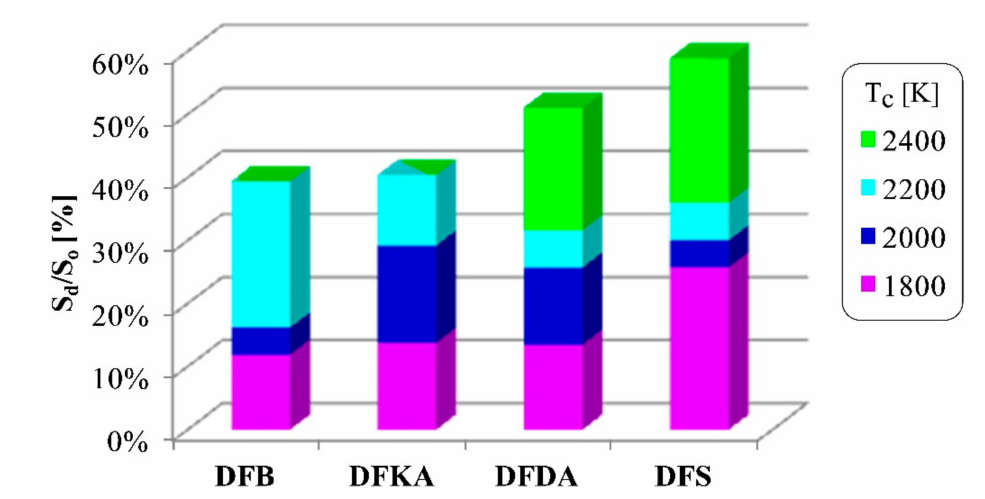
Figure 33. Surface area S d of flame in diffusion phase of combustion covered by isotherms with specific temperatures (in relation to the measurement surface area S o ) for tested